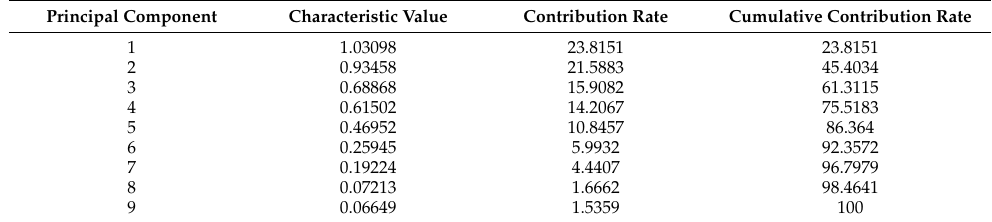
Table 3. Characteristic roots of principal components and their cumulative contribution rate.